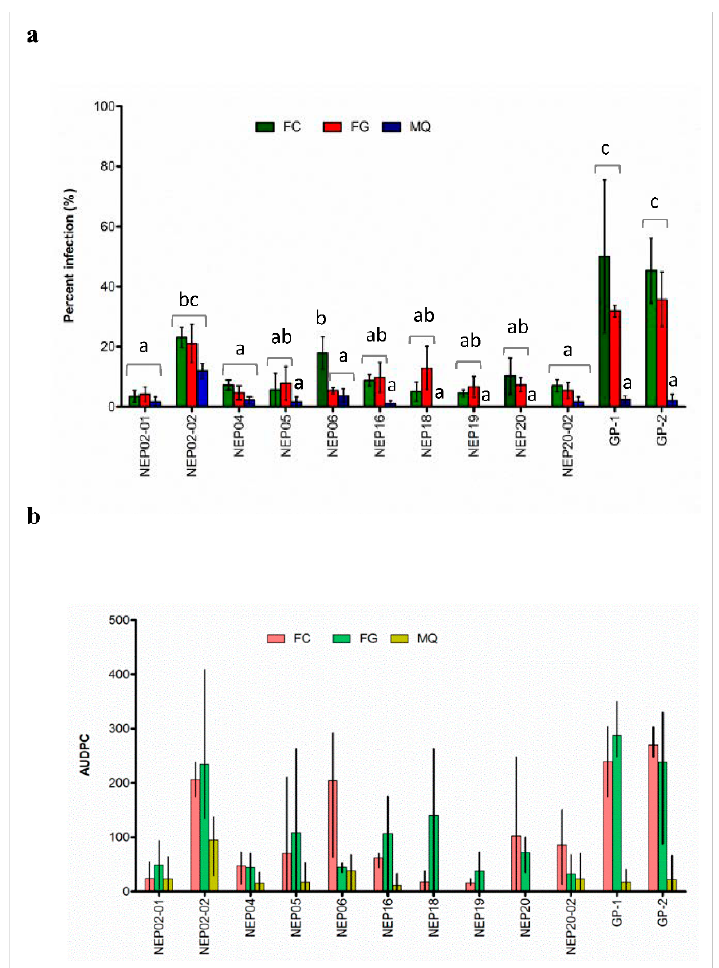
Figure 2. Transgenic barley lines overexpressing HvNEP-1 showed reduced severity of Fusarium head blight (FHB) in the greenhouse. ( a ) FHB disease severity scoring 3 weeks after inoculation with F. graminearum (FG) and F. culmorum (FC) spores and the water control Milli-Q water (MQ). Values are the mean of 3 independent technical replicates. Error bars = mean + sd. Letters on the top of the column bars indicate statistically significant di ff erences ( p = 0.05, least significant di ff erence (LSD) test); ( b ) area under the disease progress curve (AUDPC) analysis of FHB disease progression evaluated for 3 weeks after inoculation. Bars refer to the median AUDPC, and the minimum and maximum values are indicated with error bars.